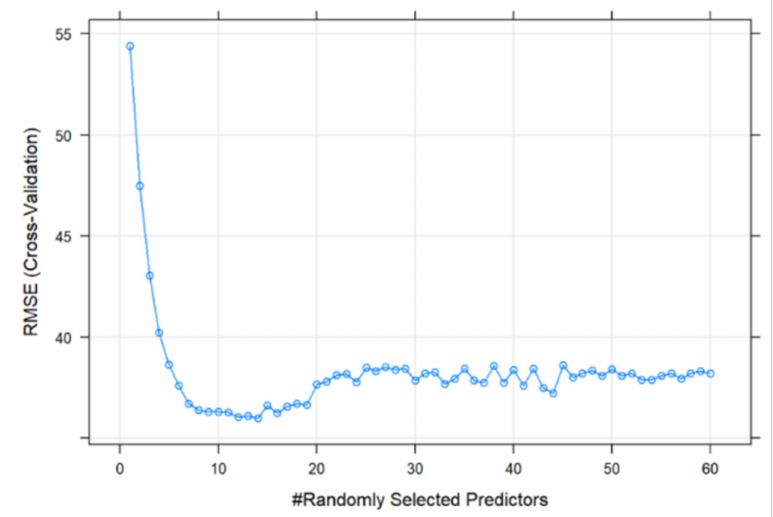
Figure 4. Model selection during training phase, Model selection: in-sample RMSE across different parameters for mtry (number of randomly selected predictors for each